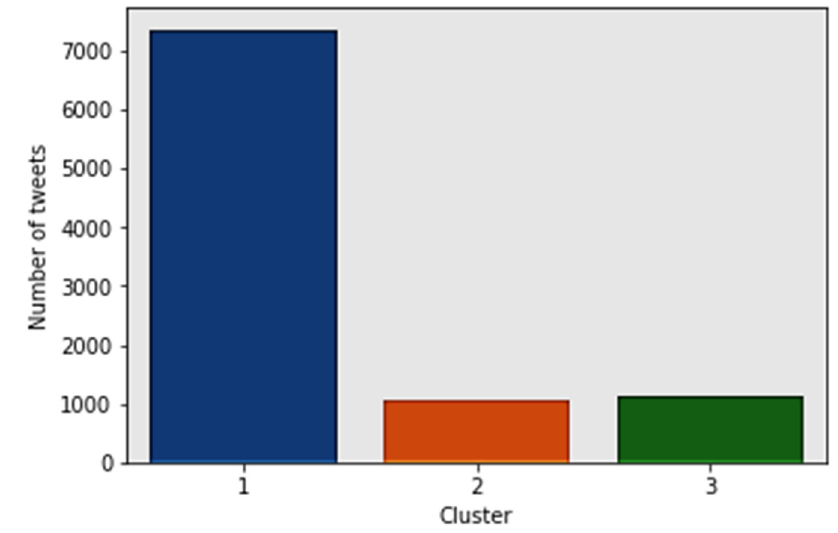
Figure 15. Tweets per cluster.